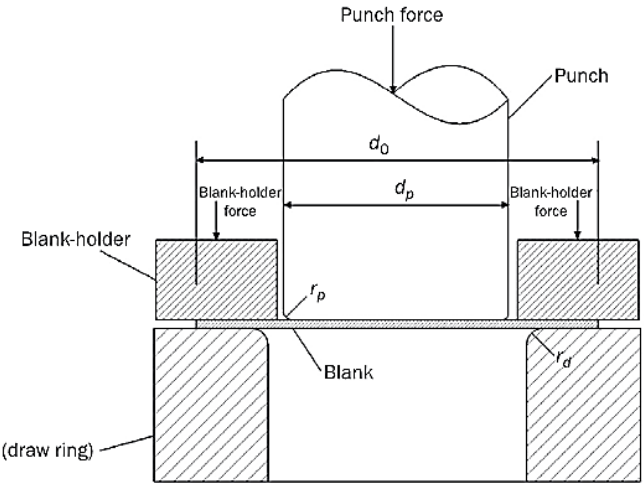
Figure 1. Conventional deep-drawing process [29].